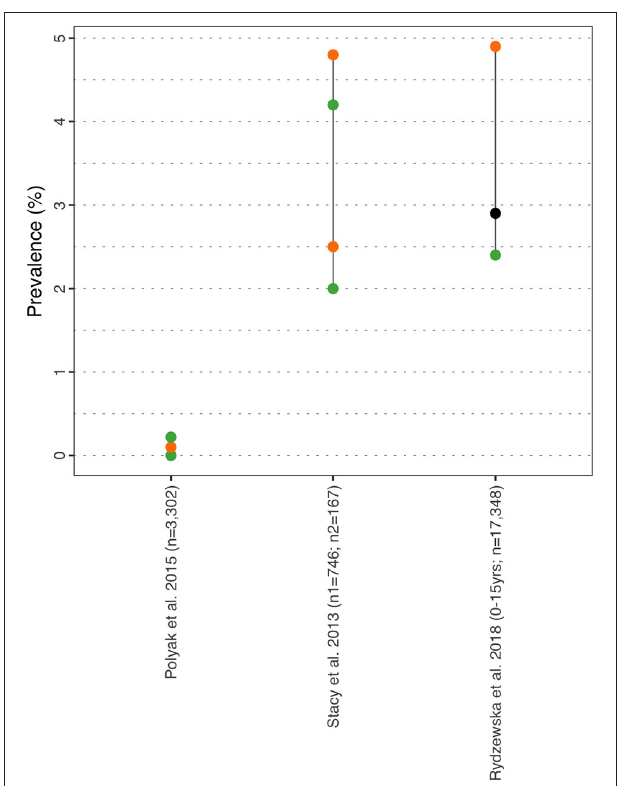
FIGURE 8 | Hearing prevalence estimates. Each point reports a prevalence estimate for the related comorbidity. Studies with more than one data point indicate the estimate of the prevalence among different subgroup of the population. See Supplementary Table 4 for the description of the population used in each study. Sample sizes are shown in brackets above each study label. Orange mark: Female population only; Green mark: Male population only; Black mark: No sex